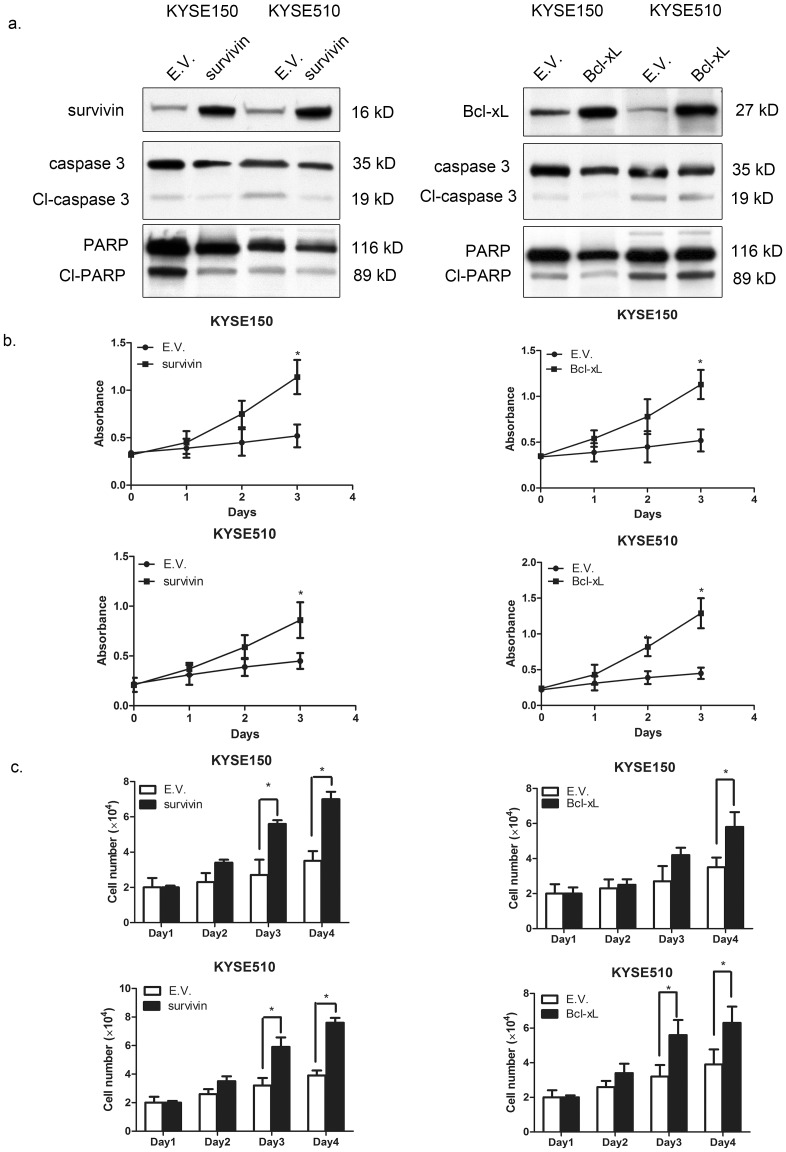
The biology functions of Bcl-xL and survivin in ESCC cell lines.Using Western blot analysis, the gene transfection of Bcl-xL and survivin in KYSE150 and KYSE510 cells was shown to be effective, since the levels of Bcl-xL and survivin were dramatically increased 2 days after Bcl-xL and survivin transfection (a). (b) In both KYSE150 and KYSE510, transfection of Bcl-xL and survivin induced a significant increase in cell growth, assessed by MTS assay. The cell numbers were assessed on 4 days after transfection. Triplicate experiments were performed independently and the results of a representative experiment are illustrated (* p<0.05). (c) Cell growth, as assessed by trypan blue cell counting, was found to be significantly increased after Bcl-xL and survivin transfection in KYSE150 and KYSE510 cells (* p<0.05). Triplicate independent experiments were performed.